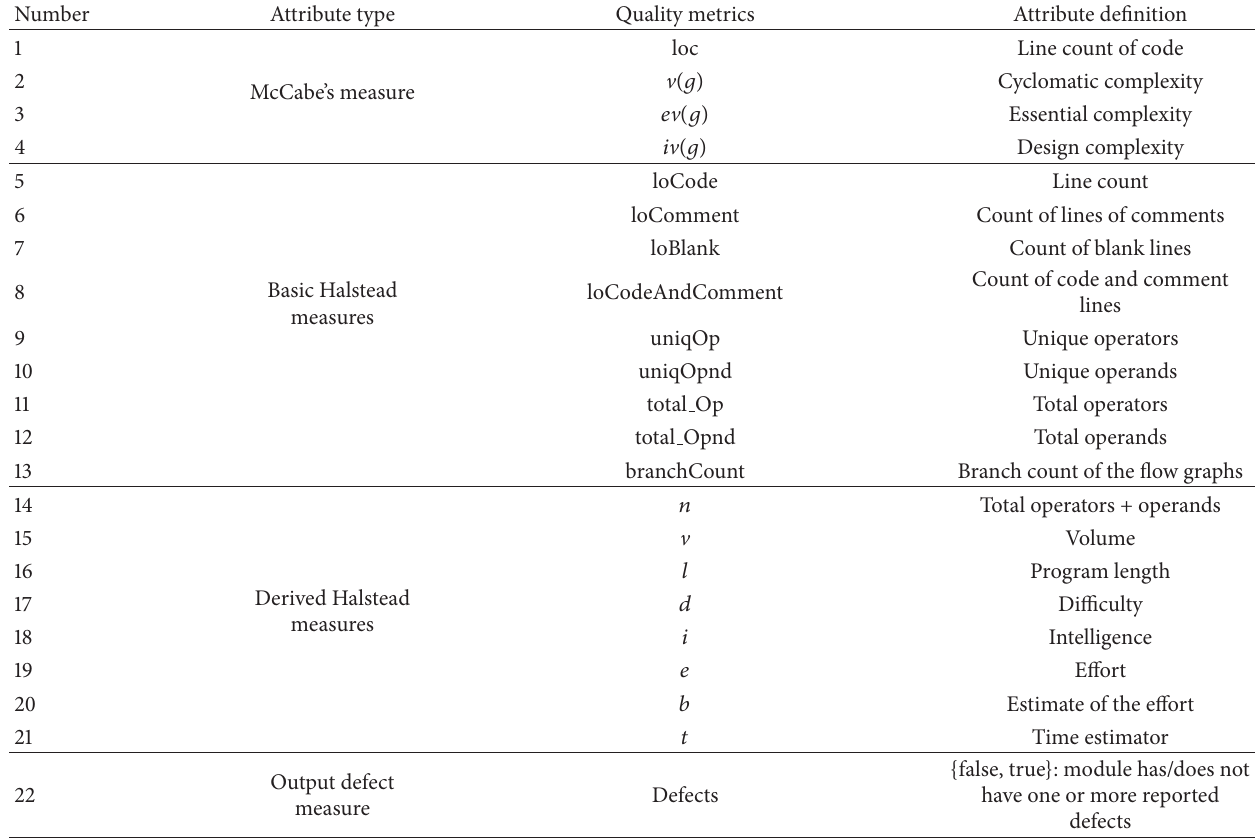
Table 2: Attribute information of the